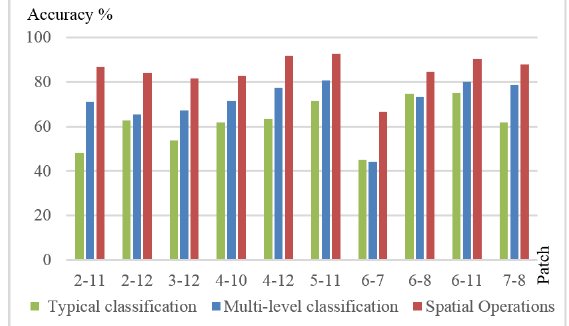
Figure 18. Car accuracy of the proposed method in test patches.